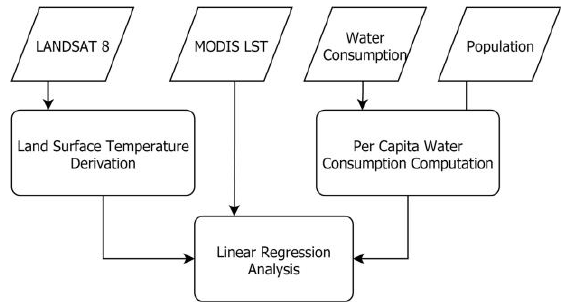
Figure 2. General workflow of the methodology of the